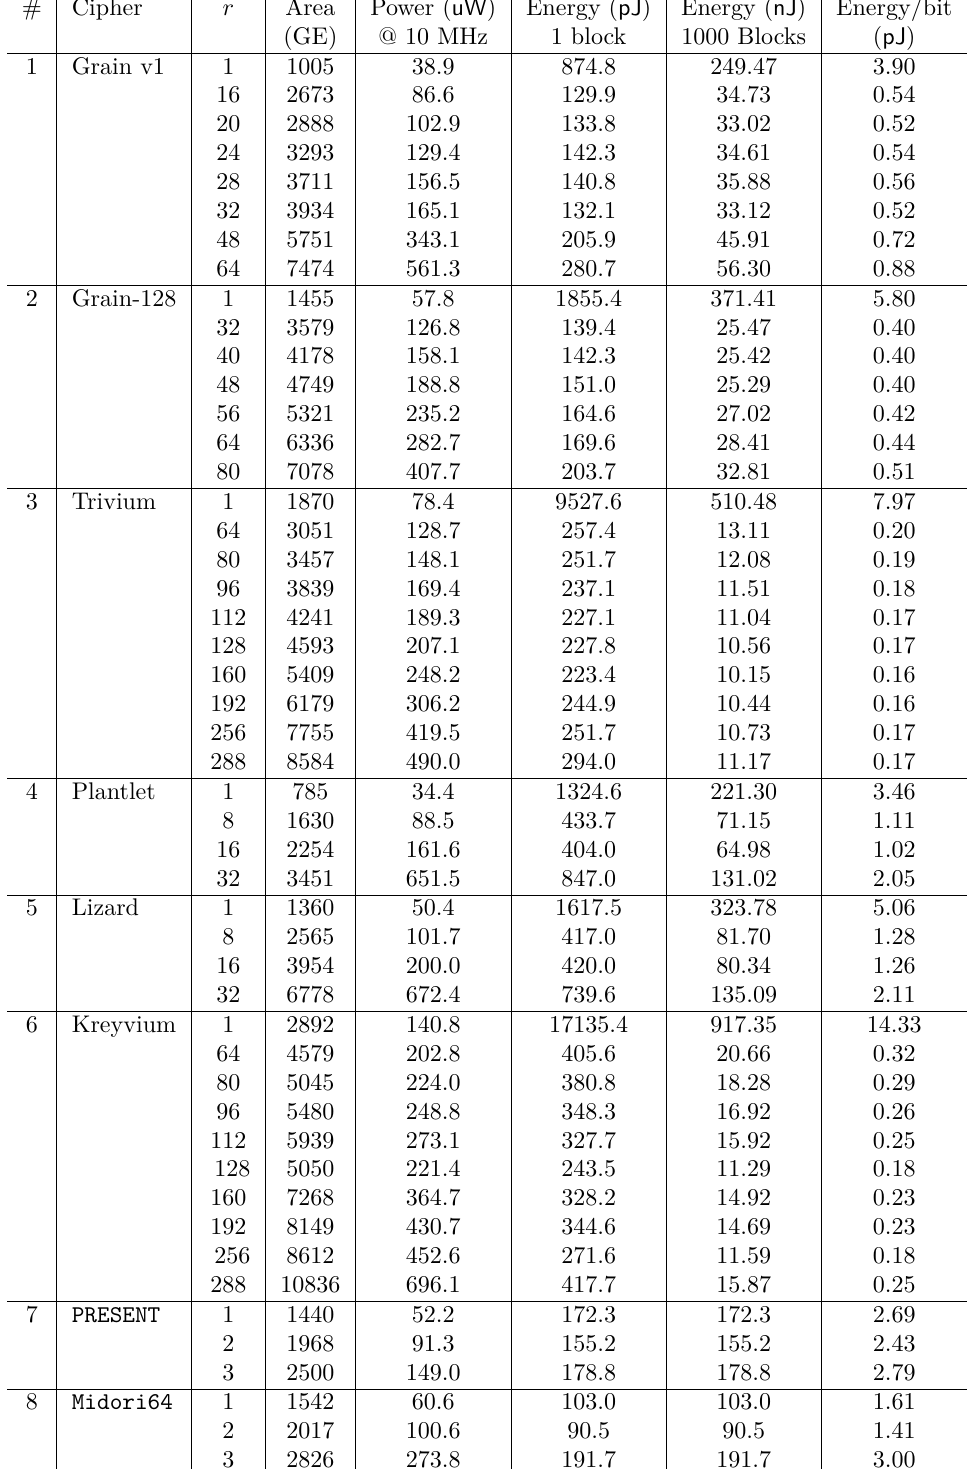
Table 4: Comparison of energy for different degrees of unrolling, r denotes # unrolled rounds, Energy/bit figure calculated over 1000